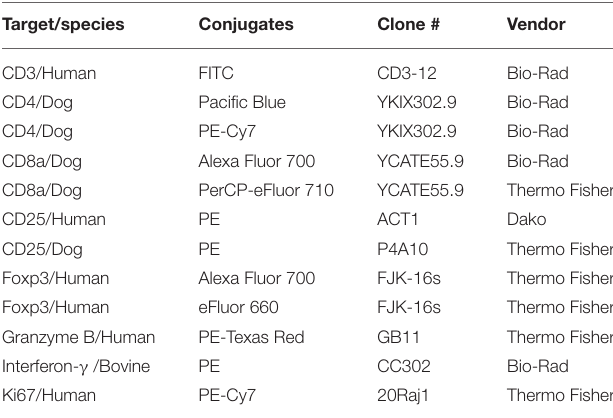
TABLE 1 | Antibodies used in flowcytometry